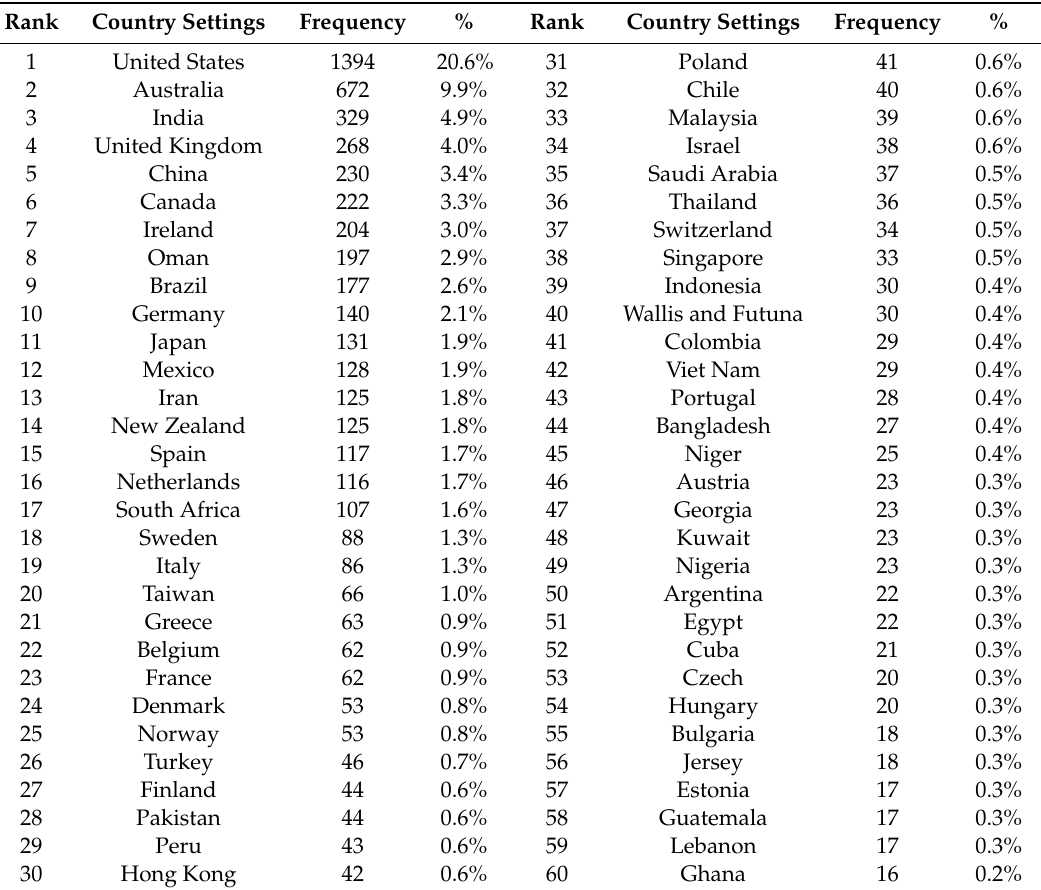
Table 3. Number of papers by countries as study settings.